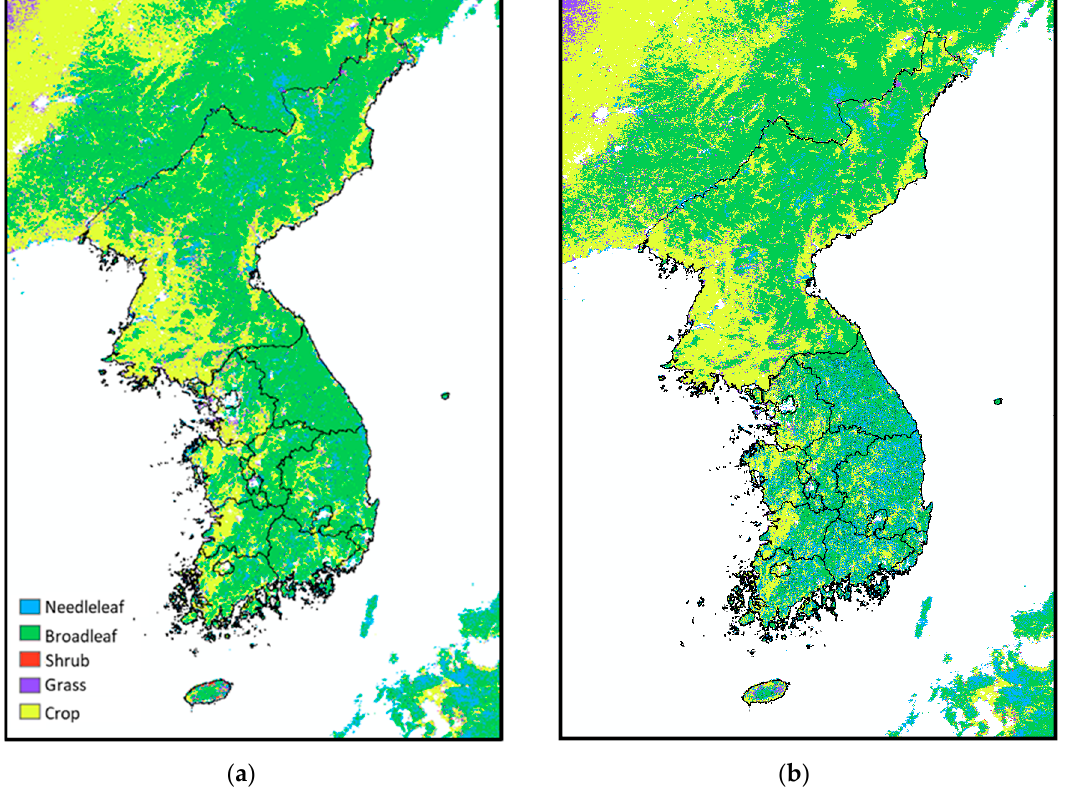
Figure 2. Land cover types for the Korean Peninsula: ( a ) Moderate Resolution Imaging Figure 2. Spectroradiometer (MODIS) Plant Functional Types (PFT); ( b ) local PFT.